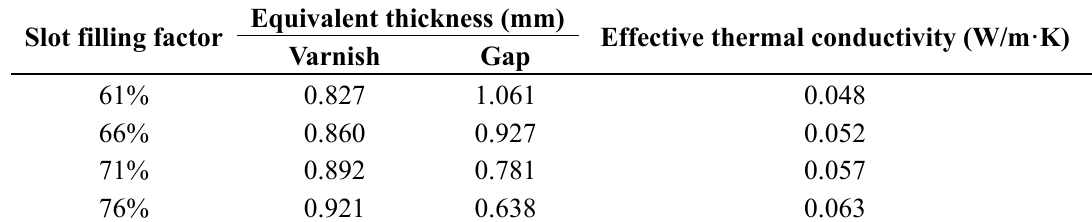
Table 7. The effective thermal conductivities of the TFPMLM with different slot filling factors.